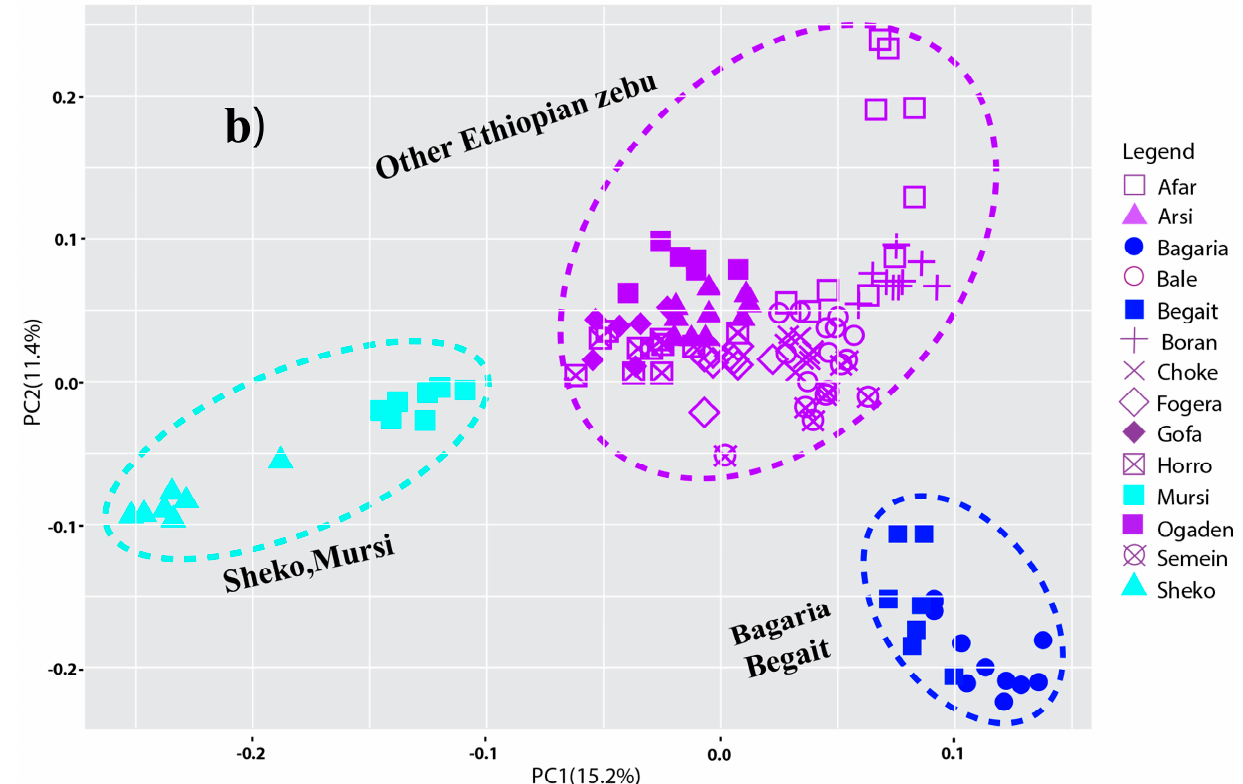
Figure 2. PCA results of ( a ) all Ethiopian and non-Ethiopian cattle populations and ( b ) only 14 Ethiopian cattle populations.